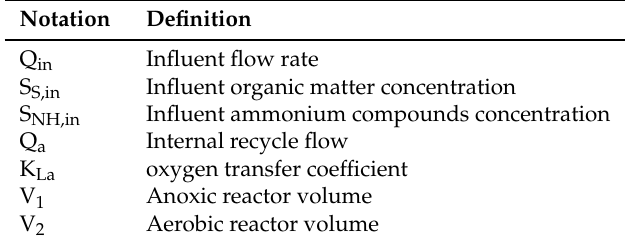
Table 2. Process characteristics.